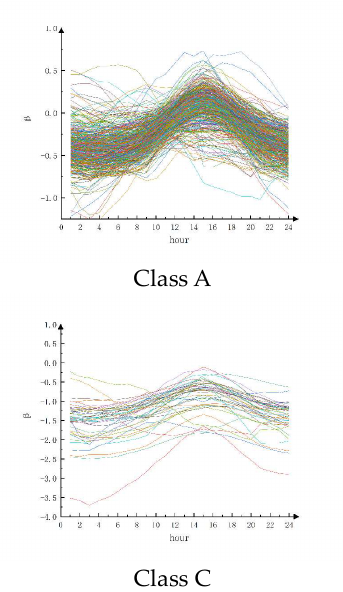
classification. classification. (cid:16) (cid:11)X3 (cid:16) (cid:11)X3